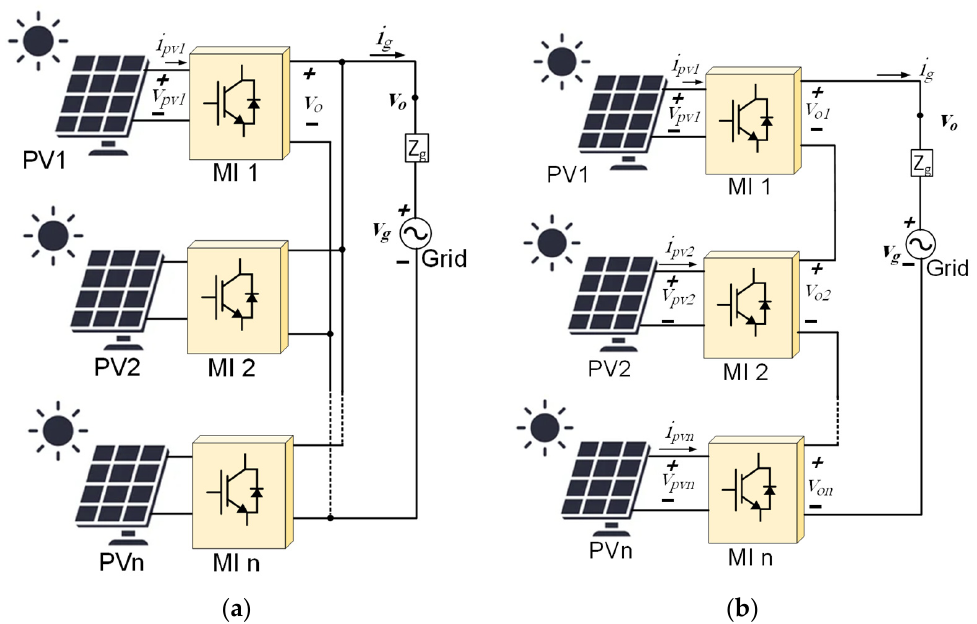
Figure 1. Low-voltage PV MI topologies: ( a ) Parallel-connected MI system and ( b ) series-connected MI system.